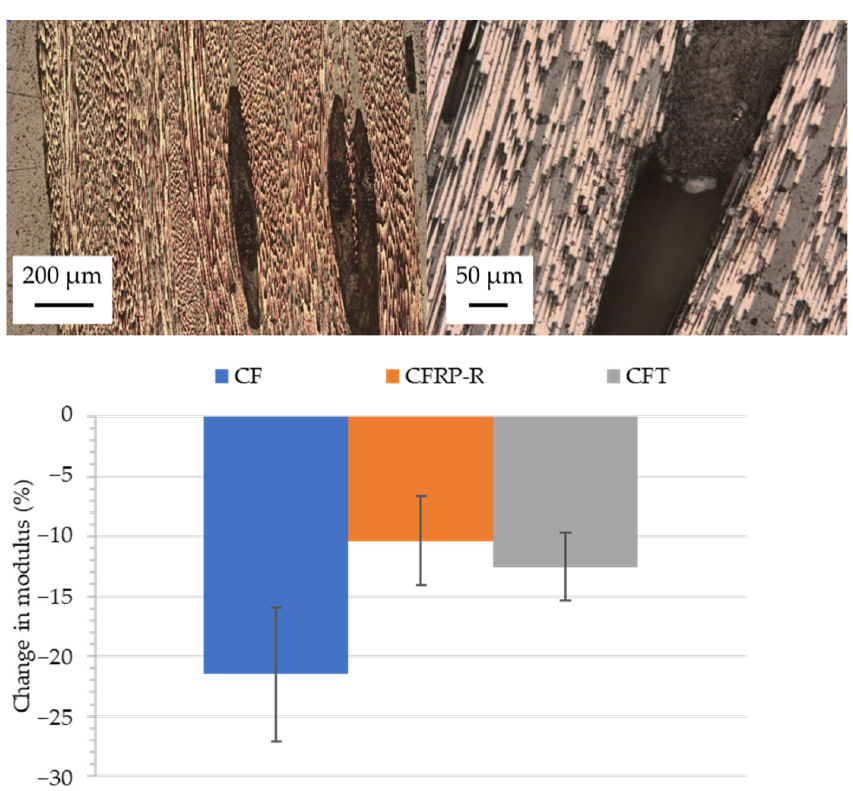
Figure 24. Stress and cycles of CFRP-R at 700 N and comparison to veil and control CFRP microscopy of failure area .